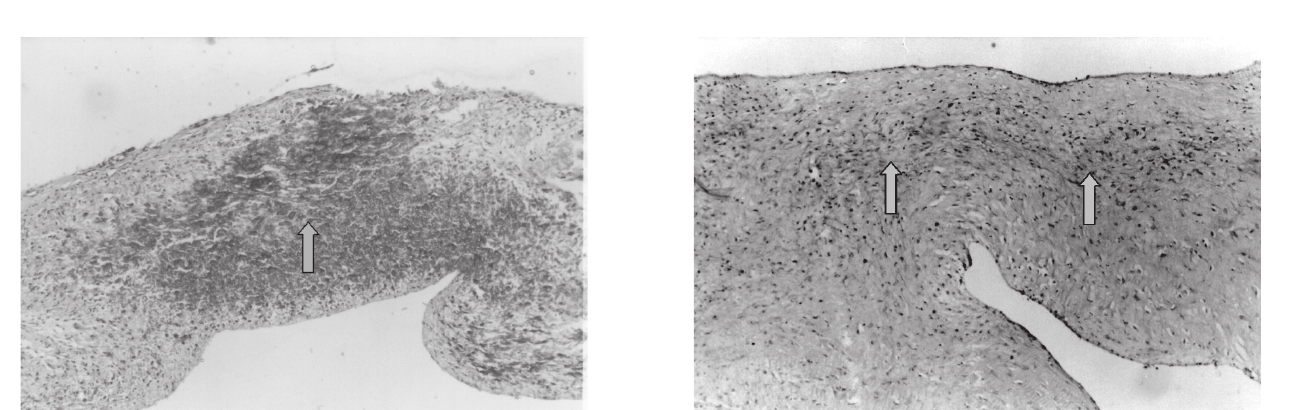
Fig. 5 - Fotomicrografia mostrando corte transversal da cúspide aórtica tratada com etanol 80%, sem sinais de calcificação após 30 dias de implante. E 80% subgrupo 30 dias (von Kossa 100x).